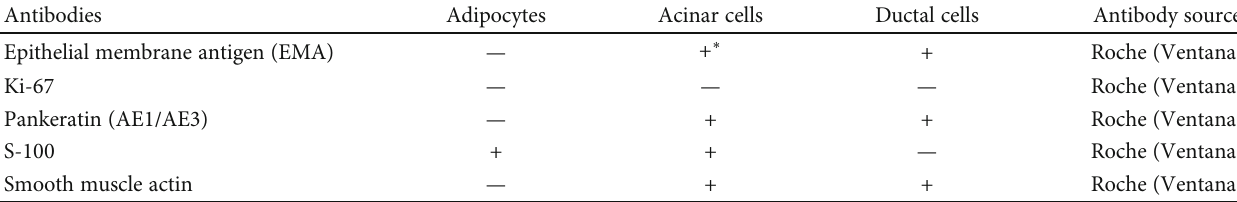
Table 1: Summary of immunohistochemical features of the fl oor of mouth sialolipoma.